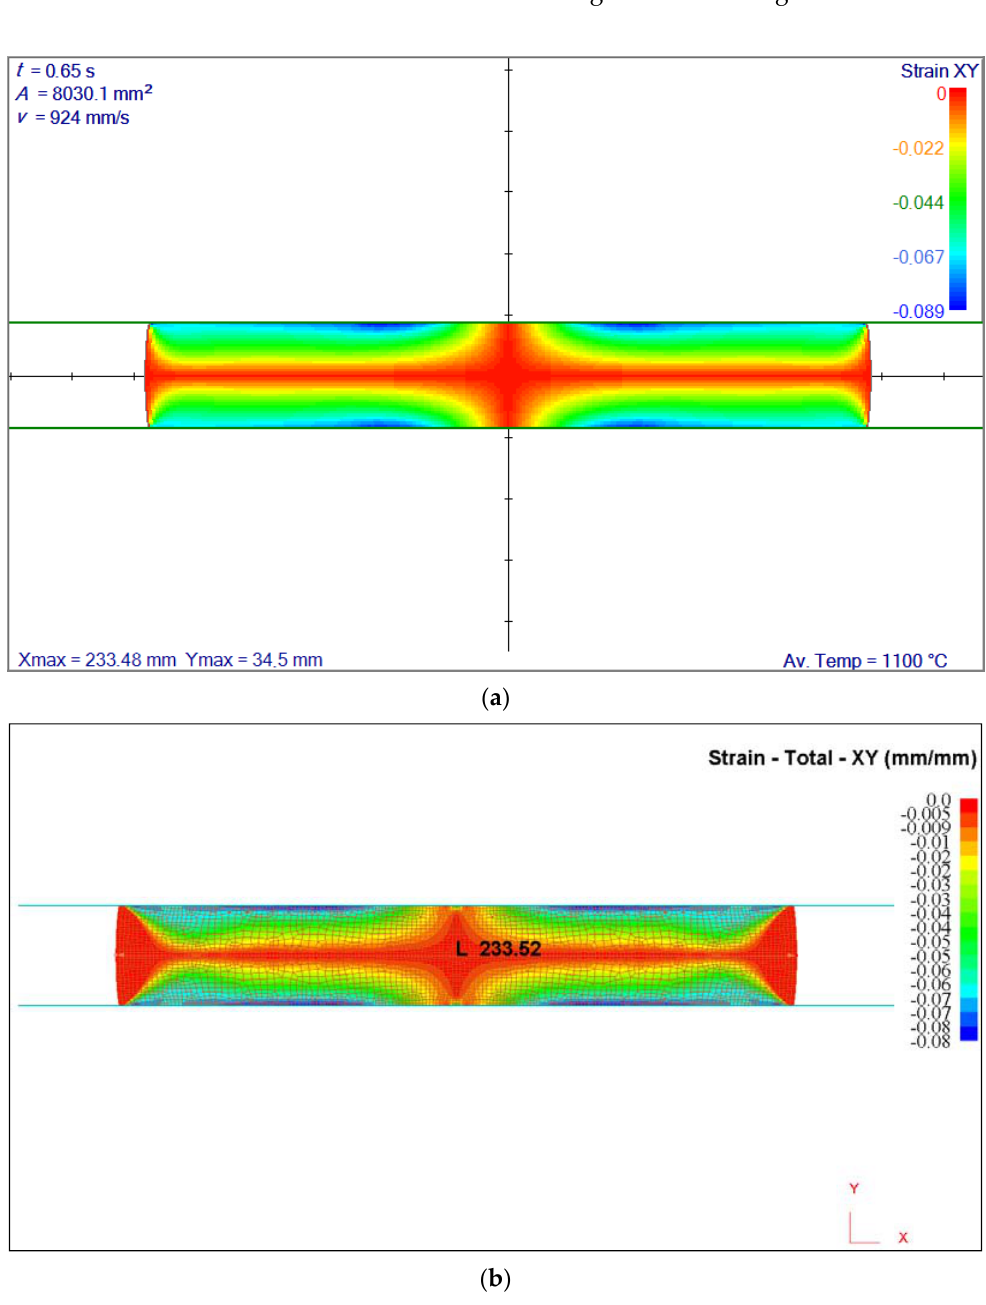
Figure 10. Comparison of strain fields. Meshless solution with irregular node arrangement is on top, FEM solution is shown at the bottom. The results of both calculations are almost the same: ( a ) 233.52 mm, ( b ) 233.48 mm. Av. Temp. stands for average temperature.